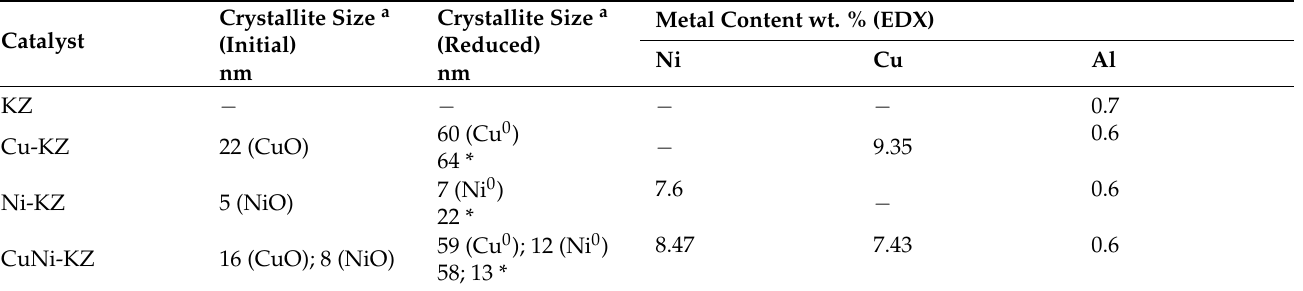
Table 1. Crystallite size of metal oxide/metallic nanoparticles and chemical composition of the studied catalysts.